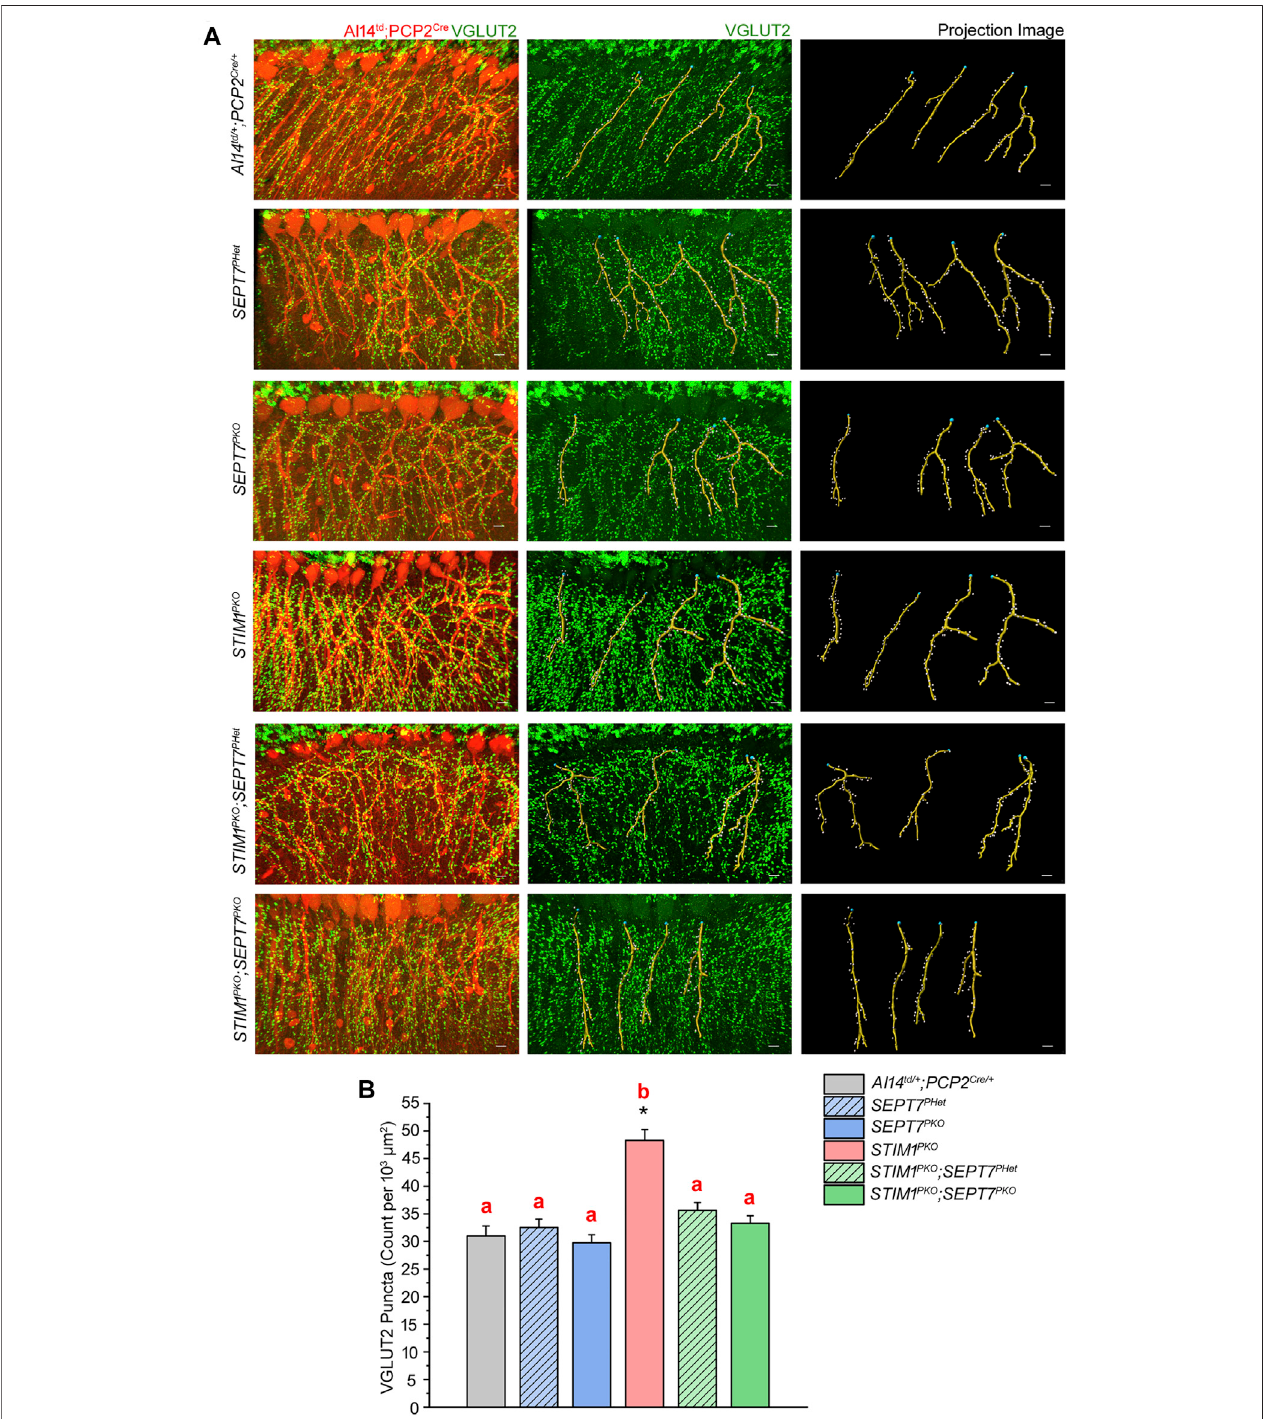
FIGURE 4 | Excess innervation between climbing fi bers and Purkinje neuron dendrites in STIM1 mice can be reversed by reduction and loss of SEPT7. (A) Immunohistochemicalimagesandquantitativeanalysisofclimbing fi berinnervationsontheproximaldendritesofPurkinjeneuronsintheindicatedmicegenotypes. (Left panel) PNsomaandproximaldendriteswithTdtomatoexpression(red).VGLUT2punctaarevisibleasgreendotsalongthedendrites; (middlepanel) VGLUT2puncta (green) with projection images of dendritic fi laments (yellow) obtained computationally using Imaris software and (right panel) projection images from Imaris analysiswithdendritic fi lamentsmarkedinyellowandVGLUT2punctaaswhitedots.Scalebarsare10 μ m. (B) BargraphdepictingthedensityofVGLUT2puncta(count per 10 3 μ m 2 ) presents at the proximal dendritic regions of PNs of the indicated mice genotypes. Quanti fi cation of VGLUT2 puncta density was from three mice of each genotype, all aged 1 year, and 27 or more PNs from each genotype. Data are presented as mean ± SEM; one-way ANOVA with post hoc Tukey ’ s test; * p < 0.00001. Same alphabets above the bar graphs represent statistically indistinguishable groups, and a different alphabet represents a statistically different group with the minimal signi fi cance of p <